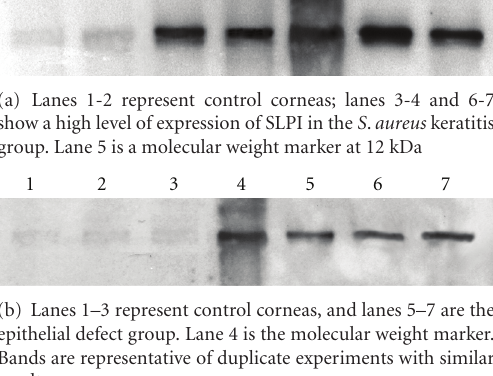
Figure 2: Representative Western blots of SLPI expression of supernatant samples from the S . aureus , the epithelial defect, and control groups of rat